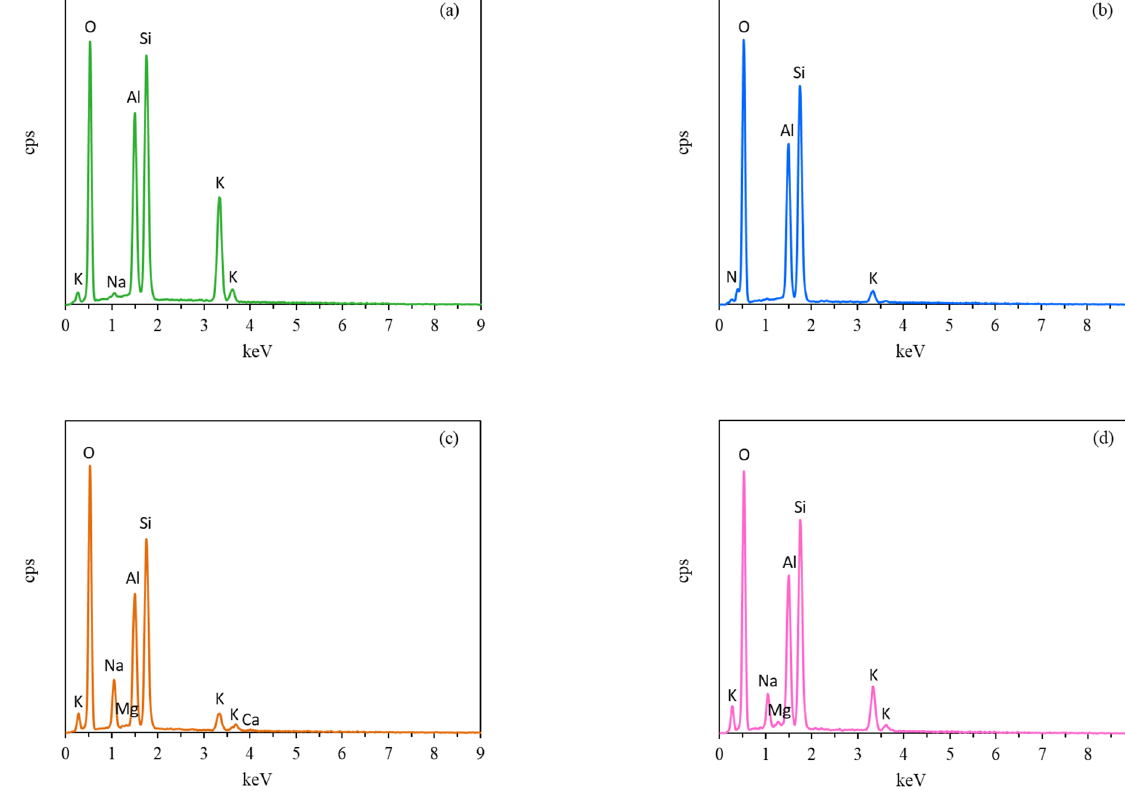
Figure 5. EDS patterns of the synthetic zeolite membranes: ( a ) unmodified KCHA zeolite membrane;